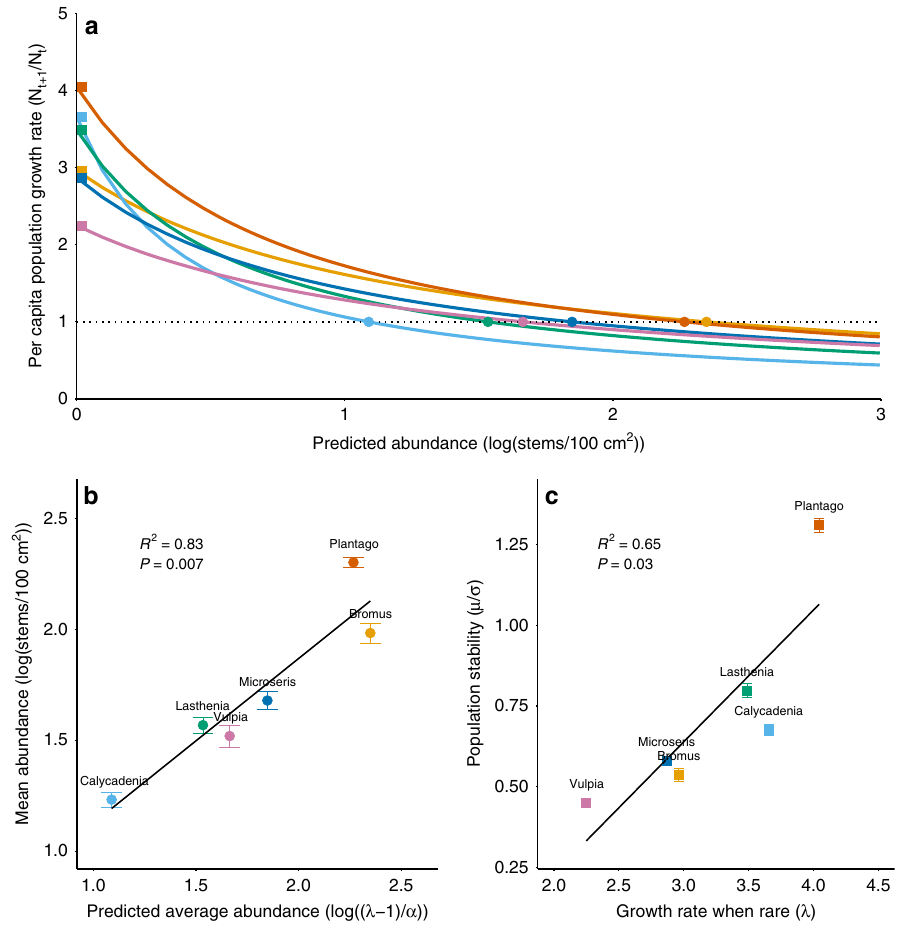
Fig. 2 Growth rate when rare and negative density dependence shape population size and stability. a Relationship between per capita population growth rate and abundance for six serpentine grassland species. Differences in species ’ average growth rates when rare (GRWR; mathematically indicated by λ and visually by squares on the y -intercept) and intraspeci fi c negative density-dependence (NDD; mathematically indicated by α and visually by the slope of the line) result in different predicted average abundances (indicated by circles on the dotted line). b Observed mean abundance over time (±s.e.m., n = 150) in relation to predicted average abundance (circles from panel a ). c Observed species stability over time (±s.e.m., n = 150) in relation to GRWR (squares from panel a